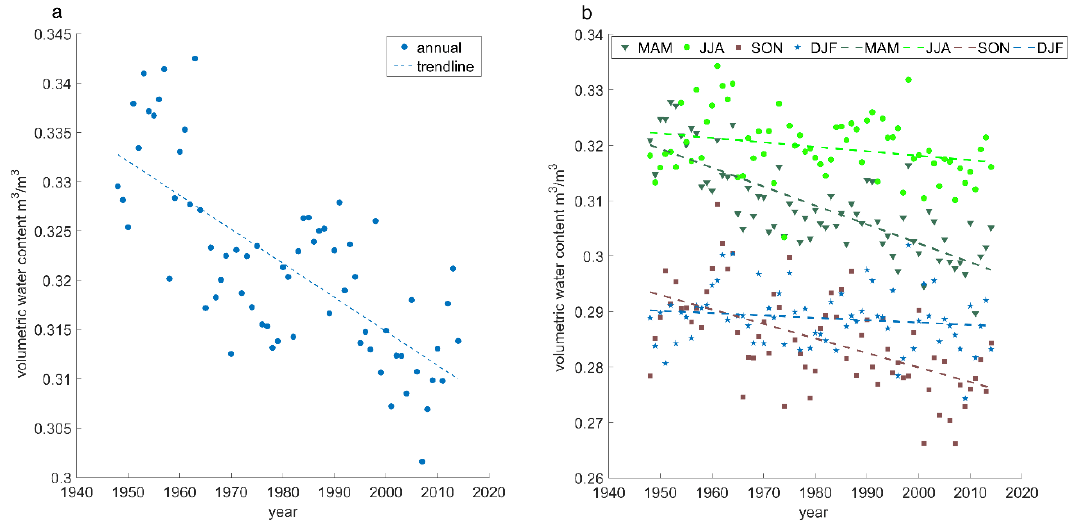
Figure 3. National interannual variations of soil moisture from 1948 to 2014 in the four seasons. ( a )